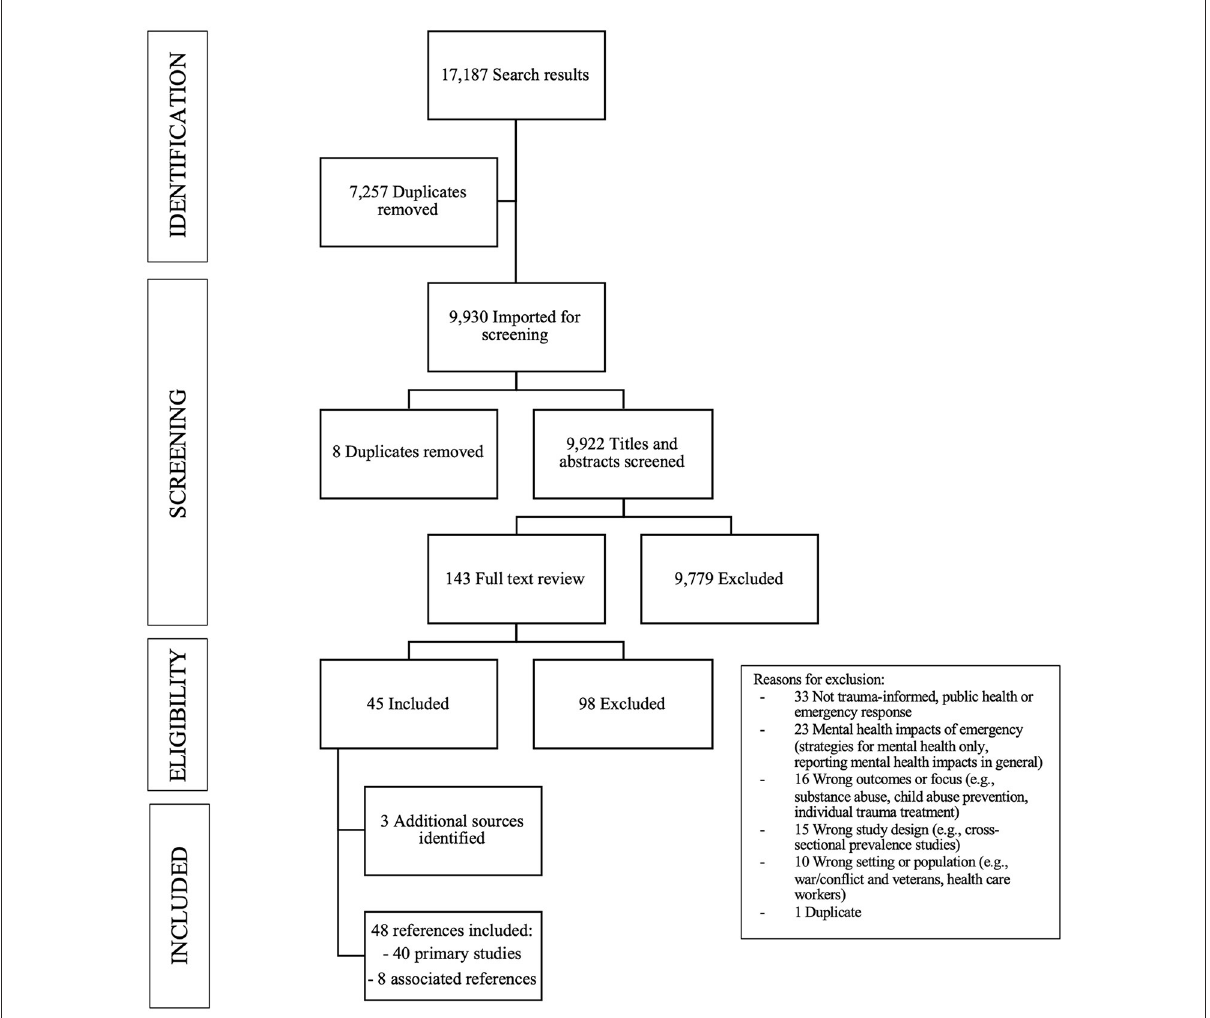
FIGURE1 Flow chart of search results, studies screened for inclusion, and reasons for